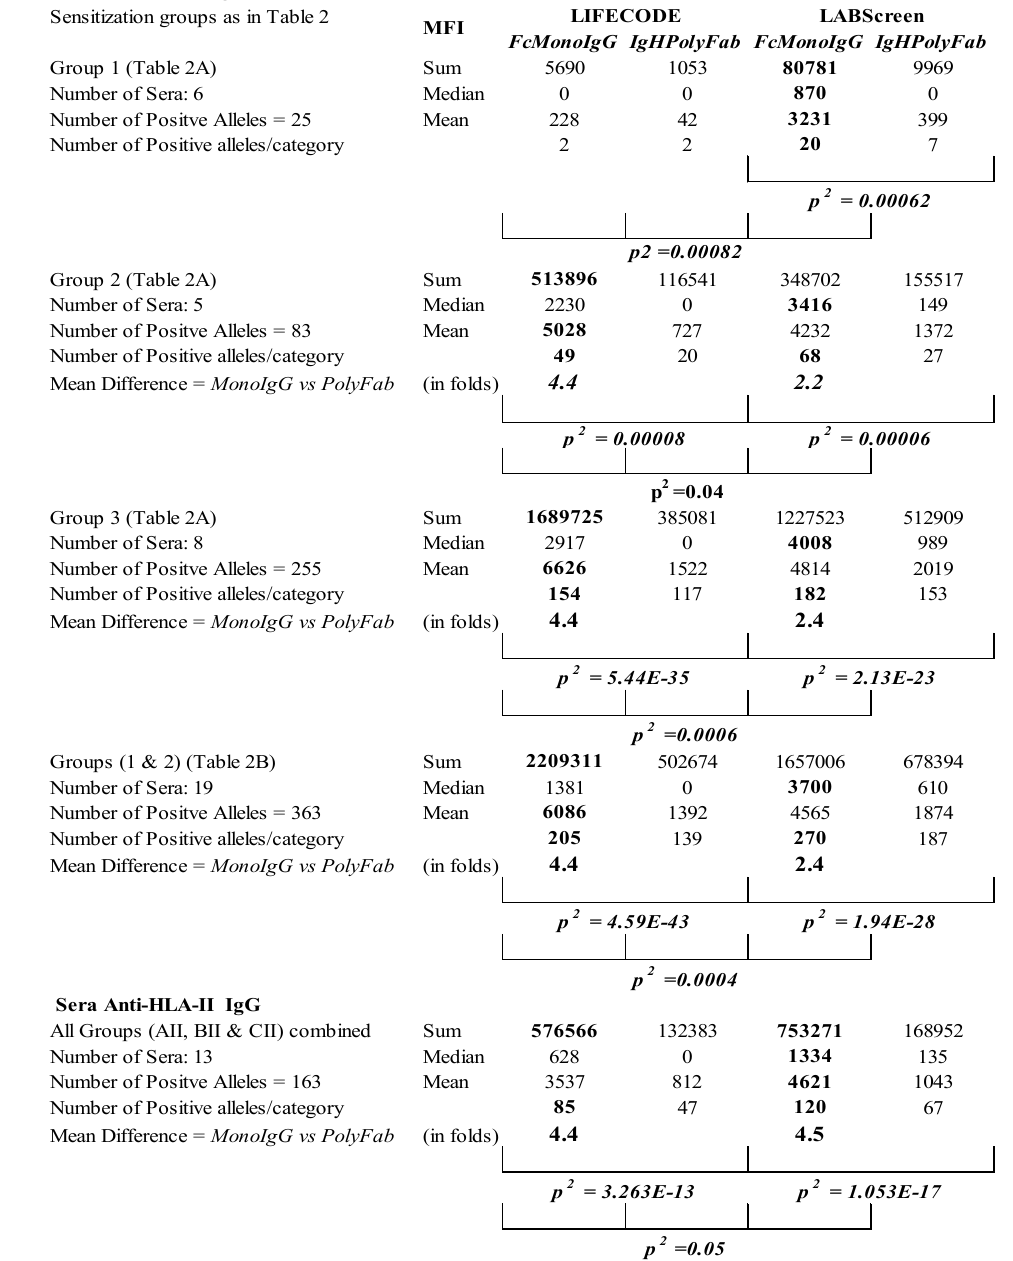
Figure 4. Summary of the profiles of MFI of anti-HLA IgG Abs monitored in the sera of ESRD patients with LABScreen (LS) and LIFECODES (LC), and with two different detection Abs ( FcMonoIgG and IgHPolyFab ). Note (1) higher sum and mean MFI values for different sensitization groups with FcMonoIgG than with IgHPolyFab (by minimum two- to maximum four-fold) and (2) the higher number of folds of increase in sum and mean MFI with LIFECODES compared to LABScreen.